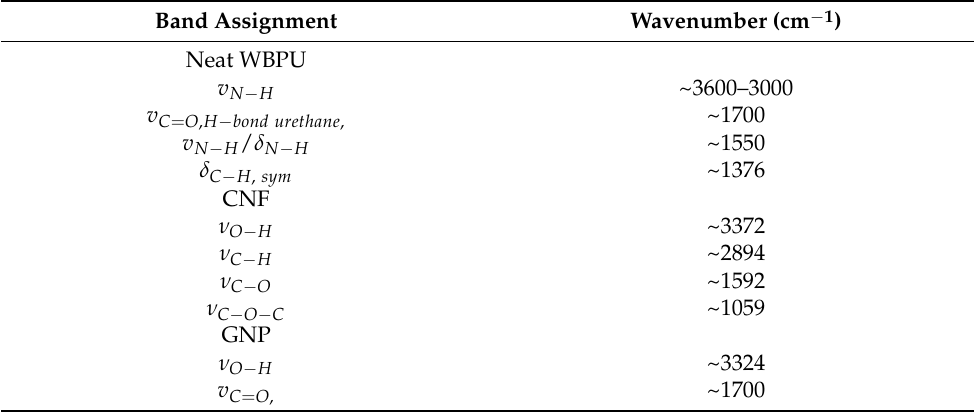
Table 2. FTIR characteristic band of WBPU, CNF and